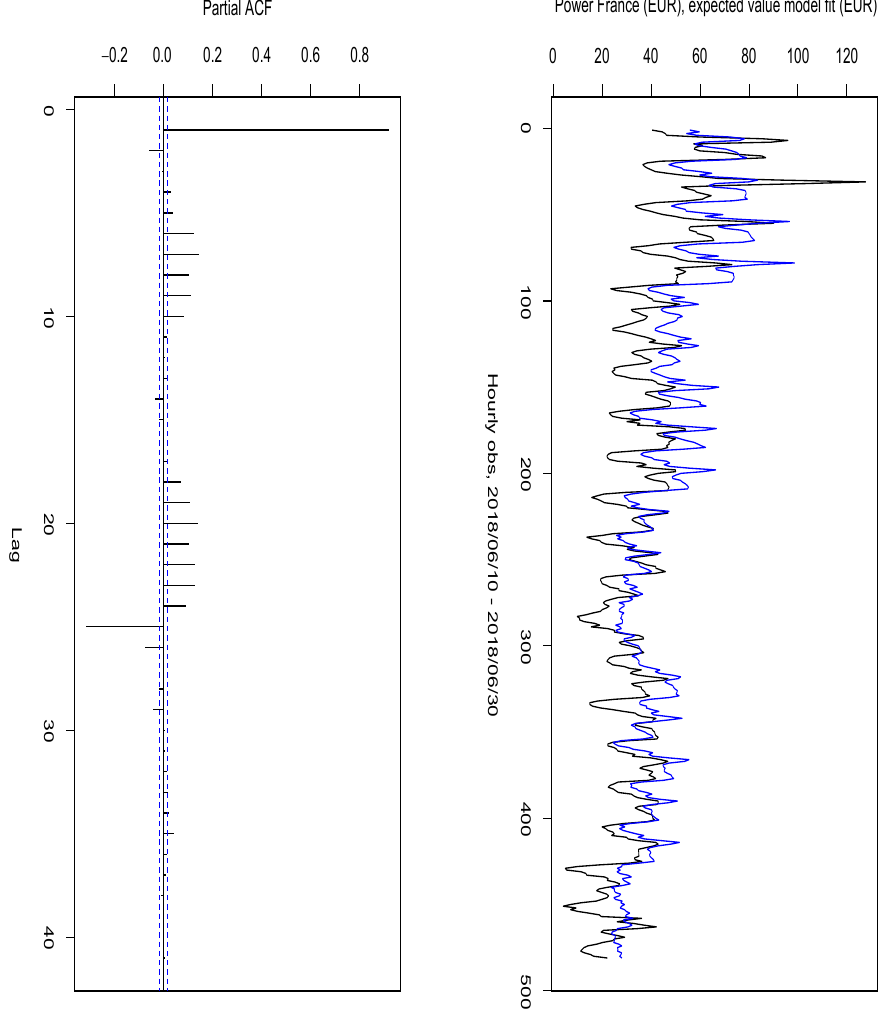
Figure 9. Top panel : blue line represents the expected value of the model in Equation (21) and black line represents the hourly time series of French power day-ahead auction. Bottom panel : the estimated partial